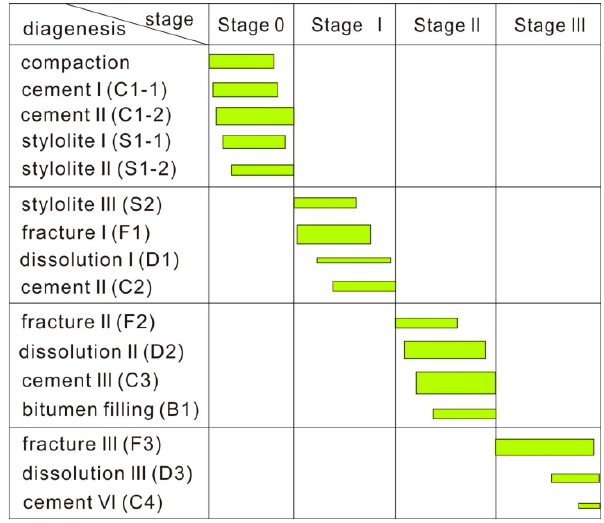
9 of 15 Figure 8. Photographs showing dissolution in the carbonate fault damage zones in the Halahatang area (the pink-dye resin showing the porosity). ( a ) Multiple dissolution in cores, the first dissolution (D1) porosity is occluded by calcite cements, the second dissolution (D2) porosity and vugs are filled with cements and bitumen, the late fracture (under arrow of D2) reactivation and opening possibly suggest third stage dissolution; H601-1, core, 6638 m; ( b ) dissolution porosity along a stylolite, H601-18, thin section, 6755.04 m; ( c ) dissolution porosity among the cataclasites, H803, thin section, 6573.78 m. 5. Discussion 5.1. Paragenetic Sequence of the Structure Related Diagenesis The relative paragenetic sequences of diagenesis are possibly inferred from fracture